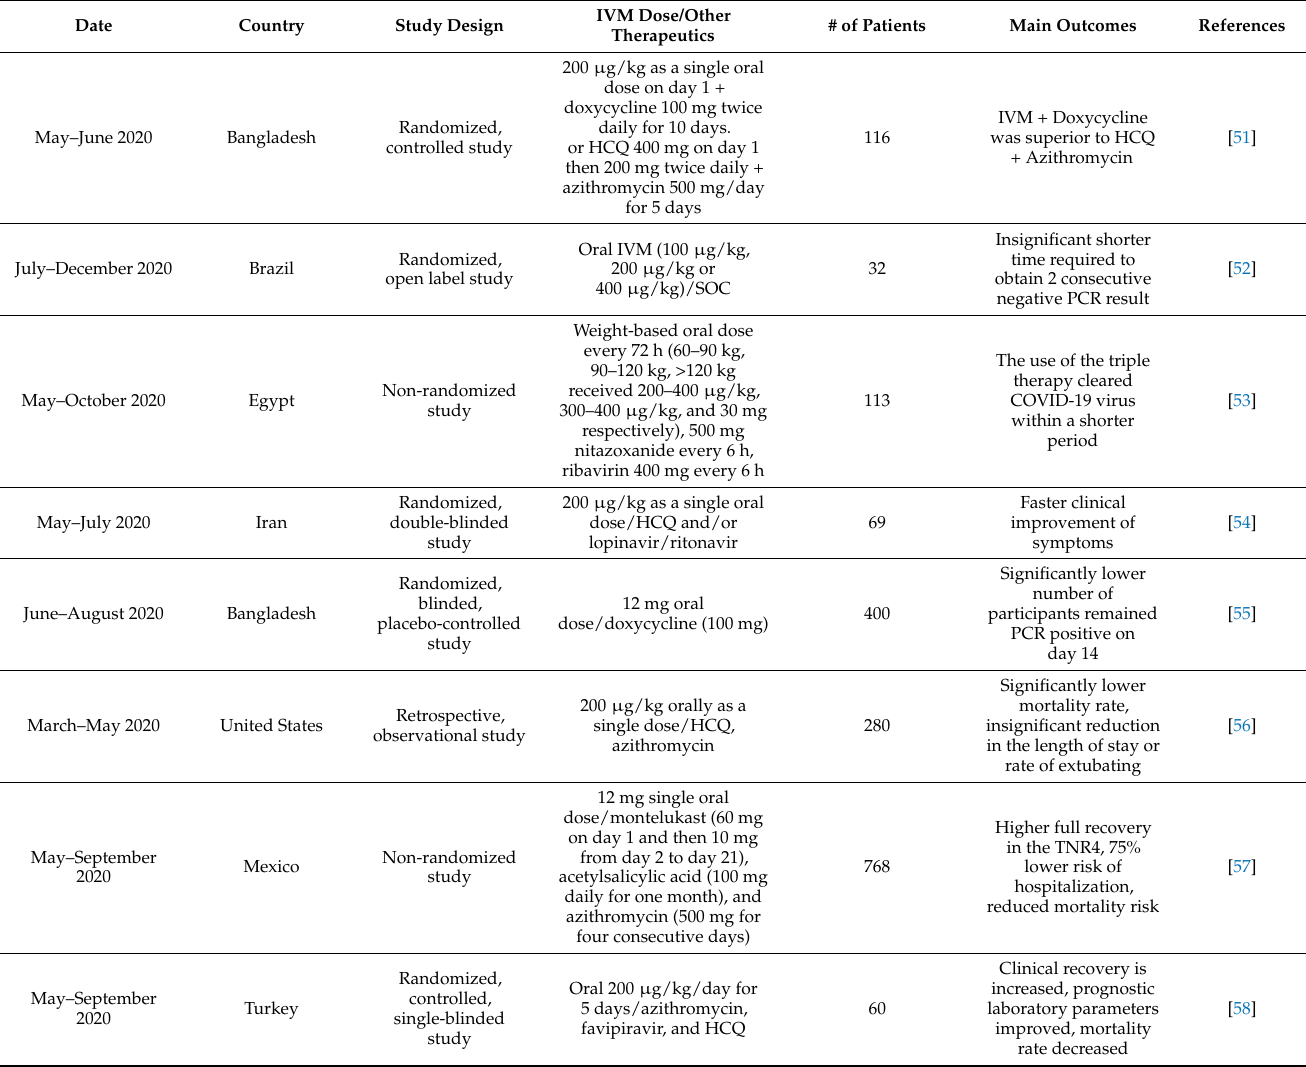
Table 3. Summary of the reviewed studies on the potential of IVM as part of combination therapies in